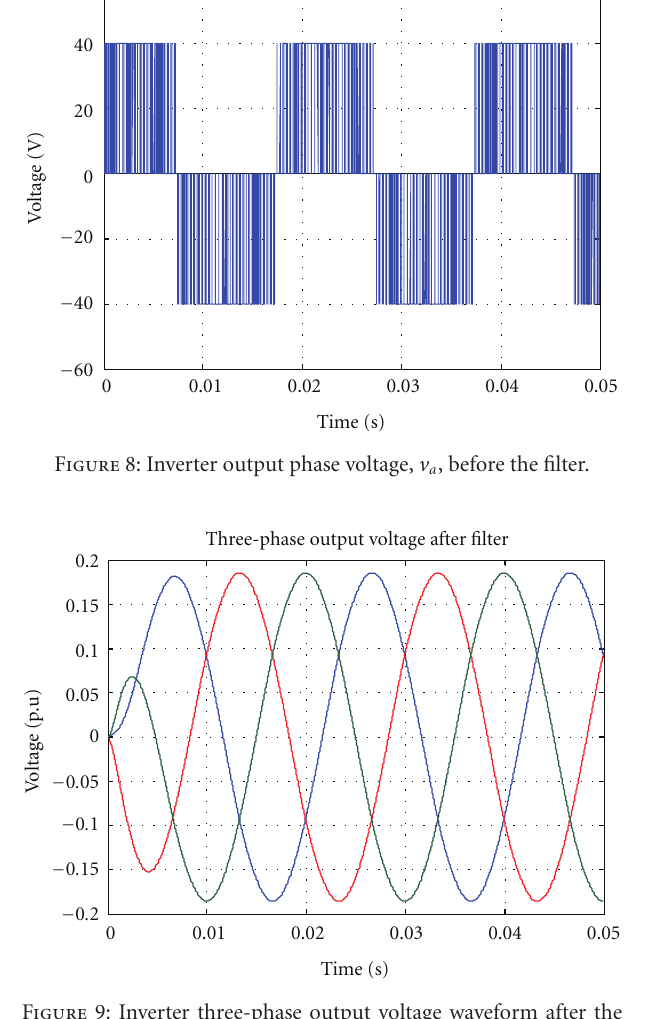
Figure 9: Inverter three-phase output voltage waveform after the filter.